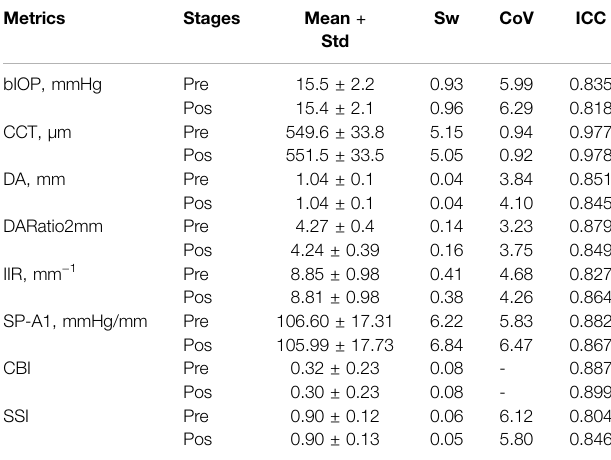
TABLE 1 | Repeatability of corvis ST parameters.